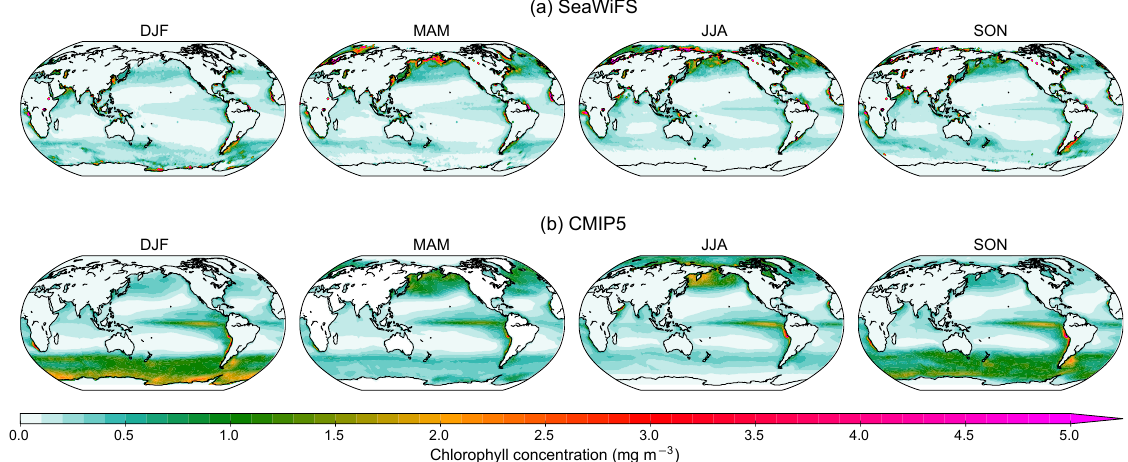
Figure 1. Maps of seasonal mean chlorophyll concentrations used as input files for the nudged simulations. The top row shows maps from the SeaWiFS satellite observational dataset from March 2003 to May 2009, and the bottom row shows the mean from CMIP5 historical simulations for the years